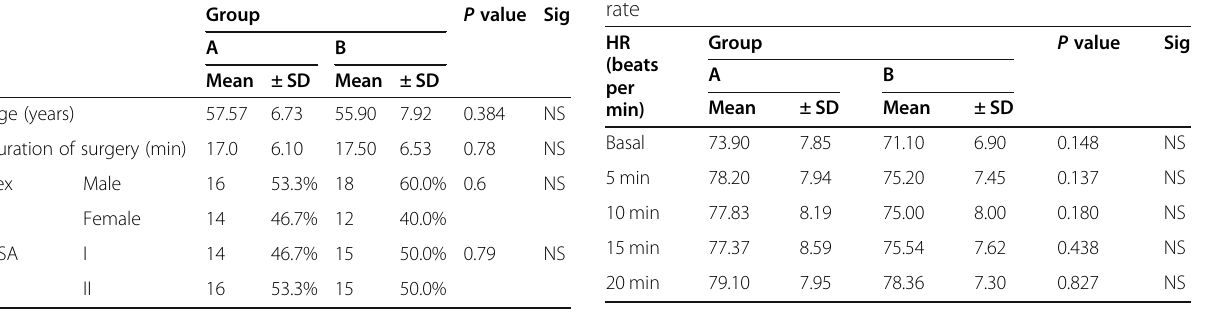
Table 3 Comparison between group A and B as regards heart